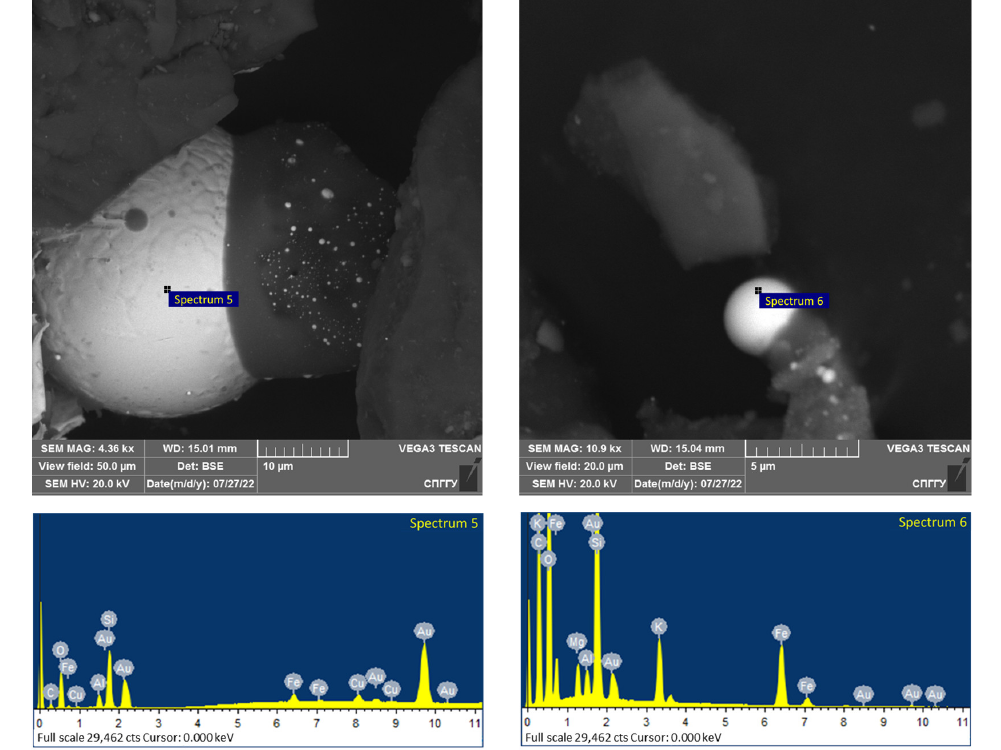
Figure 22. Results of the investigation of the CGO flotation concentrates after microwave treat-